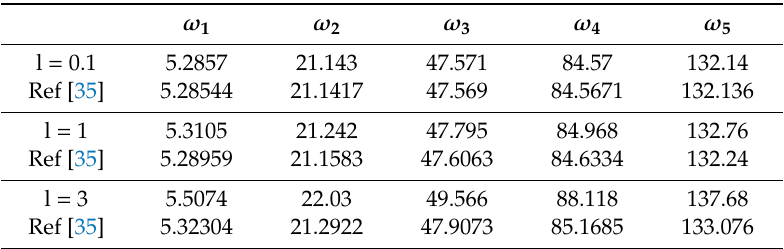
Table 2. Comparative study for the first five natural frequency of the S-S three-layer [90 ◦ ,0 ◦ ,90 ◦ ] Euler–Bernoulli